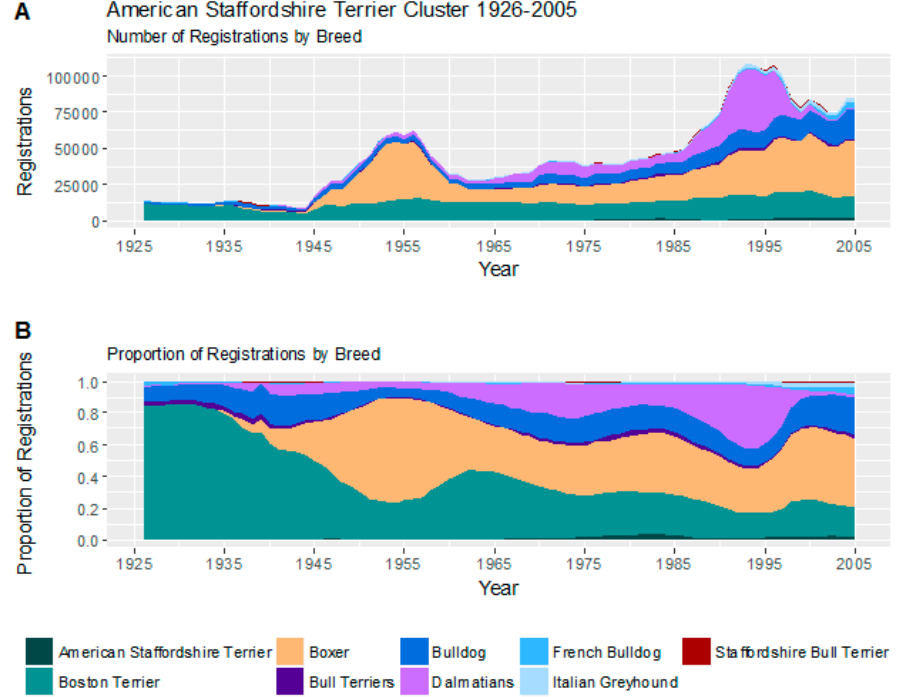
Figure 5. ( A ) Number of registrations; ( B ) and proportion of registrations within the American Staffordshire Cluster.